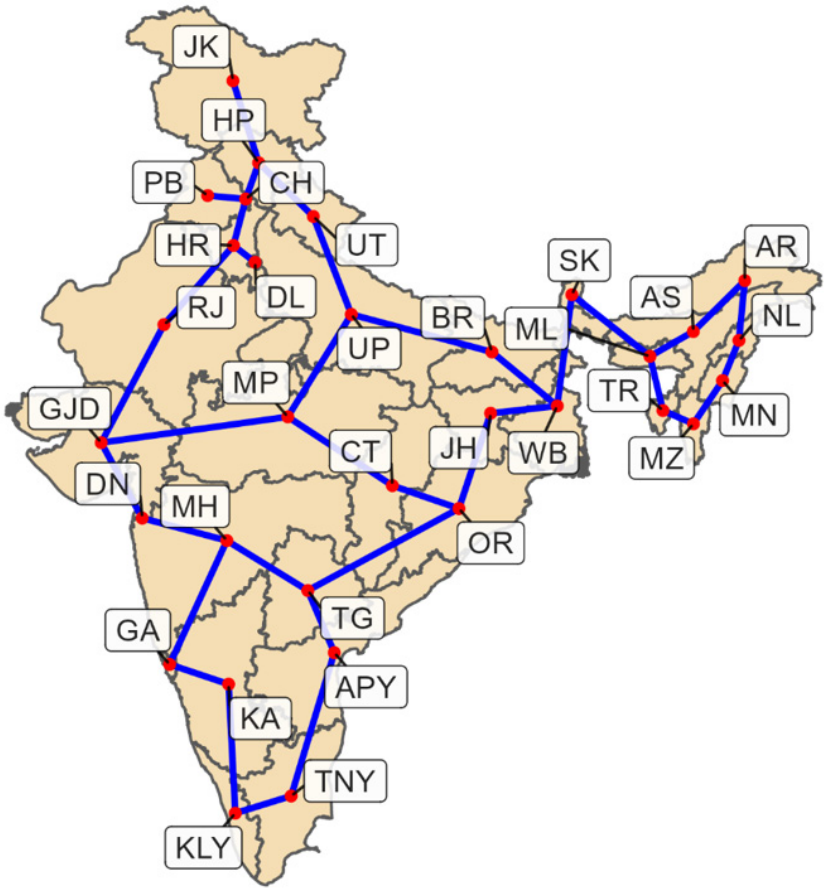
Figure 3. Simplified representation of inter-region power grid network with 36 power lines and 32 nodes.